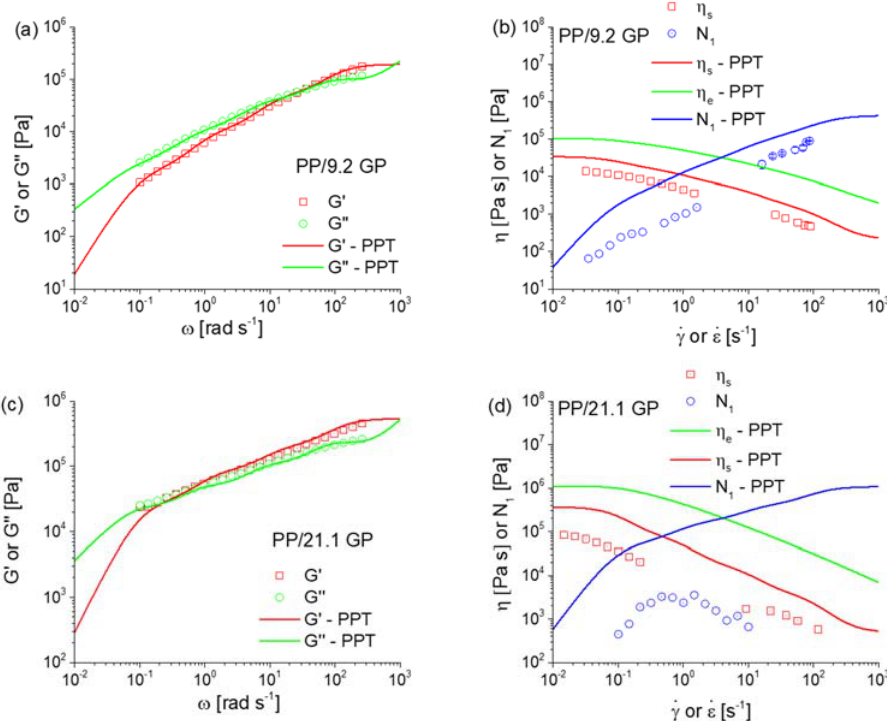
Figure 4. Update of Figure 3 in case the filler content is 9.2 and 21.1%; ( a ) G (cid:48) and G (cid:48)(cid:48) for PP composite with a graphite filler content of 9.2% (PP/9.2GP); ( b ) η s and N 1 for PP/9.2GP; ( c ) G (cid:48) and G (cid:48)(cid:48) for PP composite with a graphite filler content of 21.1% (PP/21.1GP); ( d ) η s and N 1 for PP composite with a graphite filler content of 21.1%